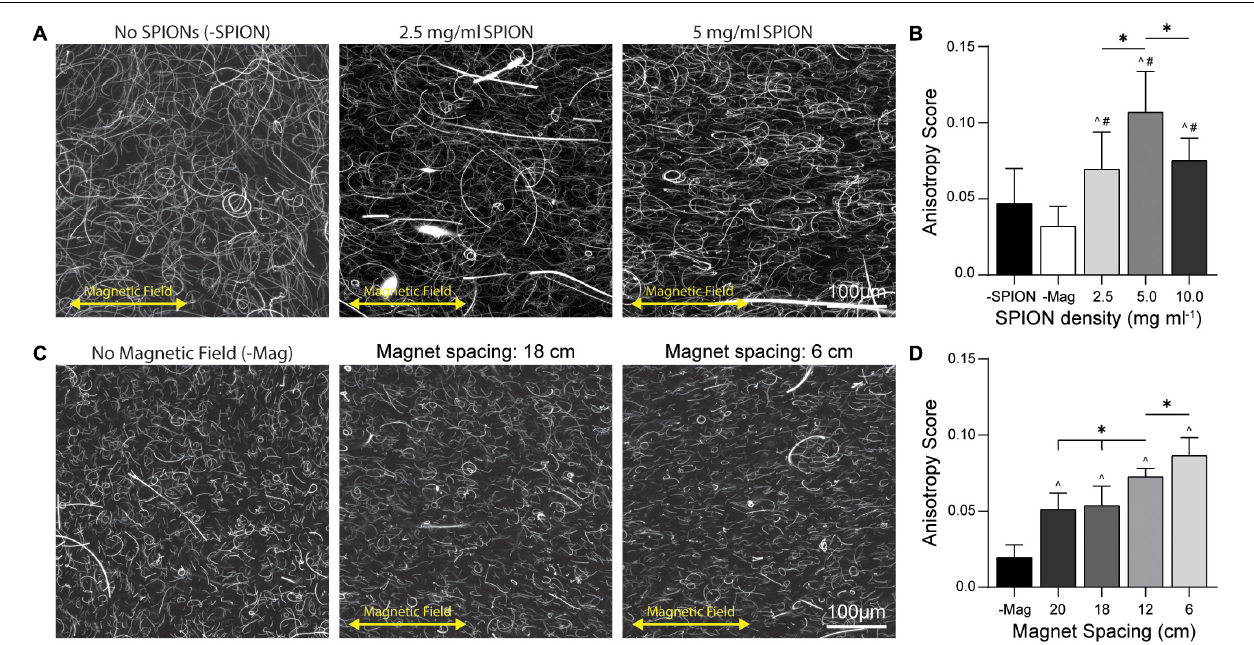
FIGURE 3 | Fiber alignment as a function of SPION density and magnet spacing. (A) Fiber alignment at 1 v/v% fiber density in 3D DVS hydrogels across a range of encapsulated SPION densities at 6 cm magnet spacing. (B) FibrilTool quantification of anisotropic fiber alignment. (C) Fiber alignment of 5 mg mL − 1 SPION fibers at 1 v/v% over a range of magnet spacings and (D) quantification of fiber alignment. All data presented as mean ± standard deviation (SD); ∗ indicates a statistically significant comparison with p < 0.05; ˆ indicates significance against –Mag; # indicates significance against